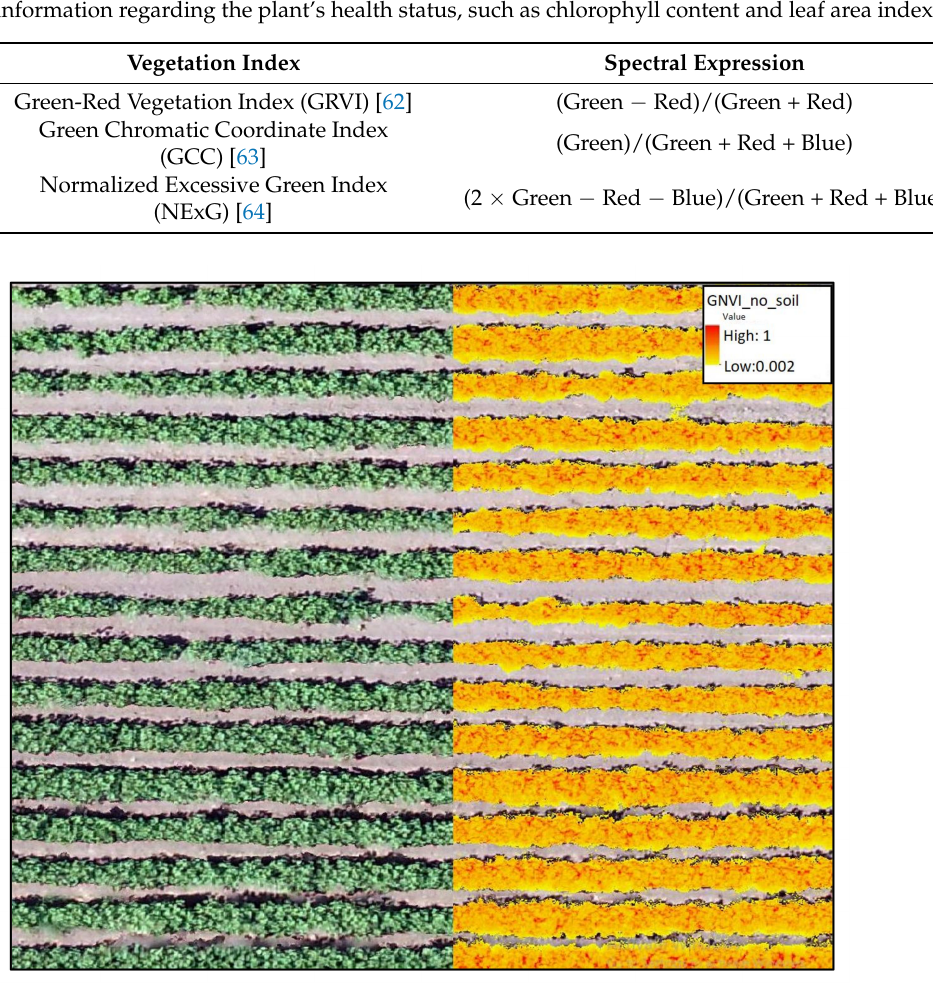
Figure 4. A segment from an RGB orthomosaic shows the elements that remain after the soil removal, namely cotton vegetation. The use of aerial imagery and digital filters enabled the isolation of the vegetation pixels from all other elements in the image, providing a more accurate and detailed picture of the ground